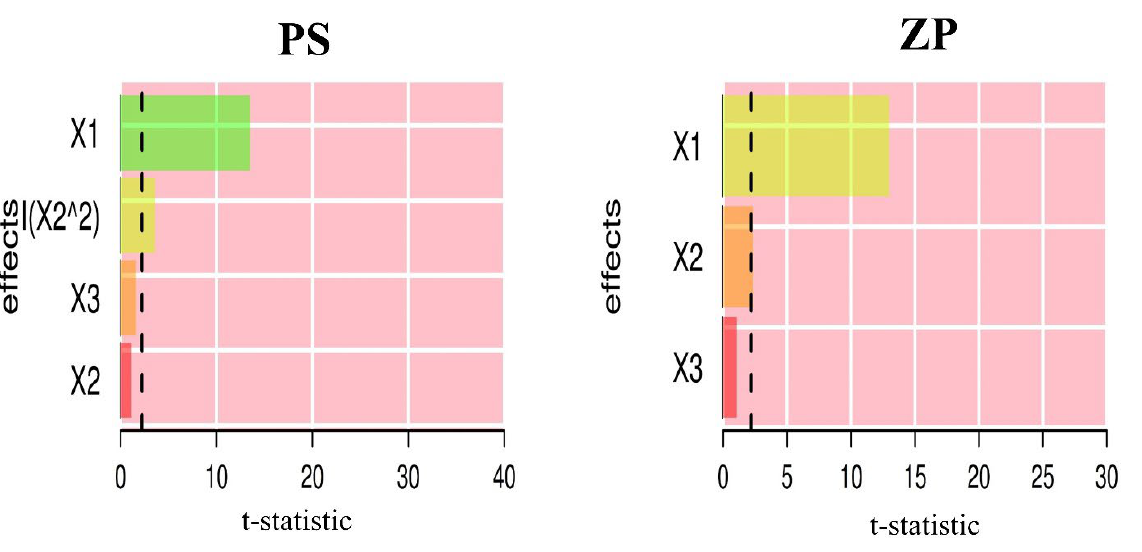
Figure 3. Pareto charts depicting the standardized impacts of independent variables: GMO concen- tration (X 1 ), P 407 concentration (X 2 ) and T 80 concentration (X 3 ). 3.2. Characterization of Optimized GS-CBS 3.2.1. Morphological Evaluation The optimized GS-CBS formulation morphologically exhibited distinct cubic struc- tures with no evidence of large aggregates (Figure 4), which may be attributed to the steric stability and electrostatic repulsion generated by the high ZP ( − 31.6). The average particle size was smaller when the TEM micrographs were compared to the Zetasizer results. This could be because TEM imaging was executed on dried materials [48].